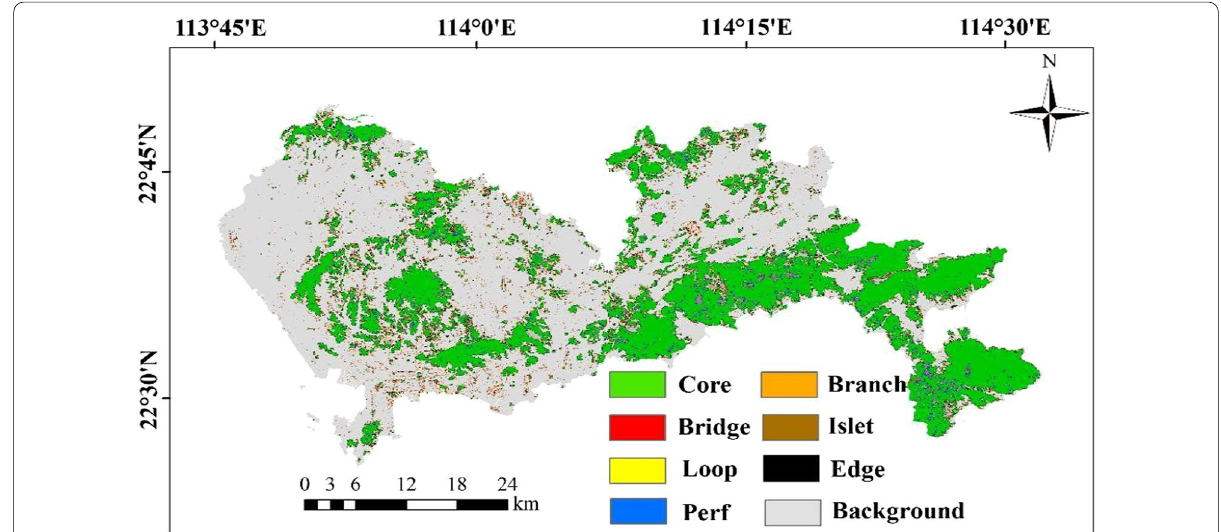
Fig. 3 Spatial distribution of landscape patterns (e.g., Core, Bridge, Loop, Perf, Branch, Islet, Edge, and Background) in Shenzhen City